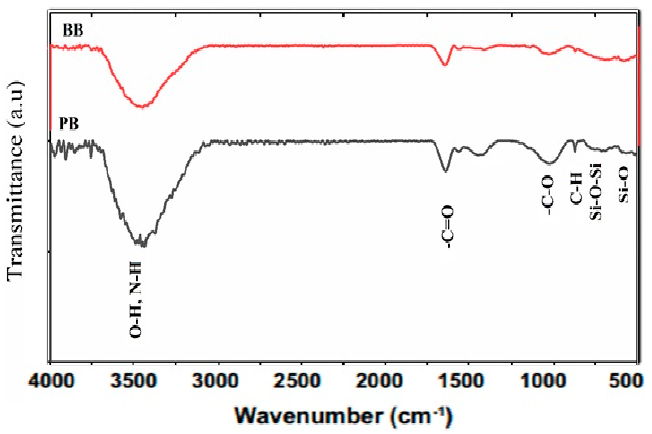
Figure 2. Fourier-transform infrared (FTIR) spectroscopy of tested biochar.